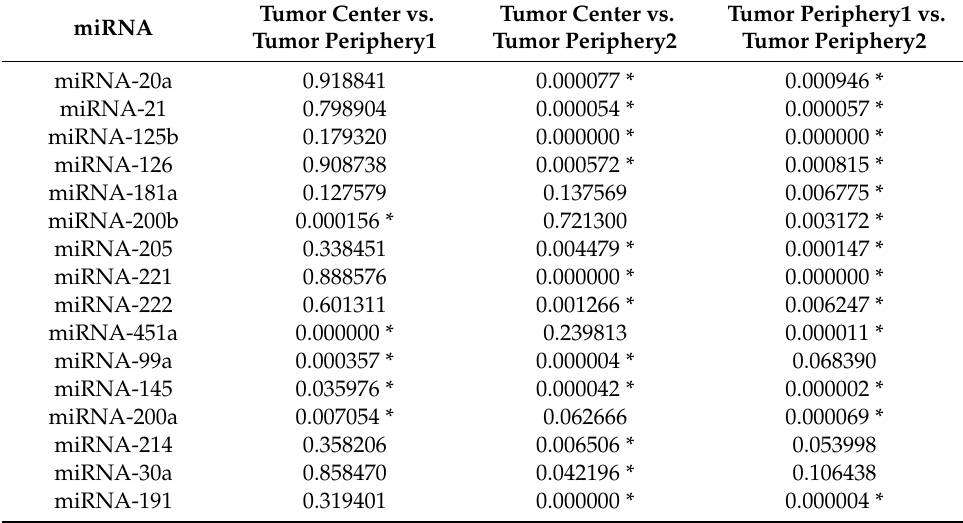
Table 4. Significance level of di ff erences in miRNA expression between specimens taken from intratumor areas. Tumor Center vs. miRNA Tumor Periphery1